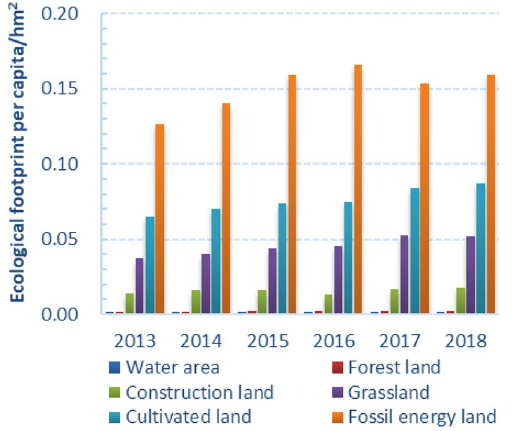
Figure 4. Trends of six types of ecologically productive land in Guangdong Province from 2013 to 2018.